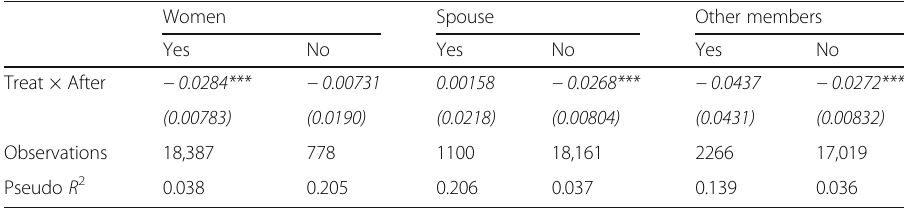
Table 10 Effect of AUH on the probability of entering the labor force. Heterogeneities: who are in charge of domestic chores? Women Spouse Other members Yes No Yes No Yes No Treat × After − 0.0284*** − 0.00731 0.00158 − 0.0268*** − 0.0437 − 0.0272*** (0.00783) (0.0190) (0.0218) (0.00804) (0.0431) (0.00832) Observations 18,387 778 Pseudo R